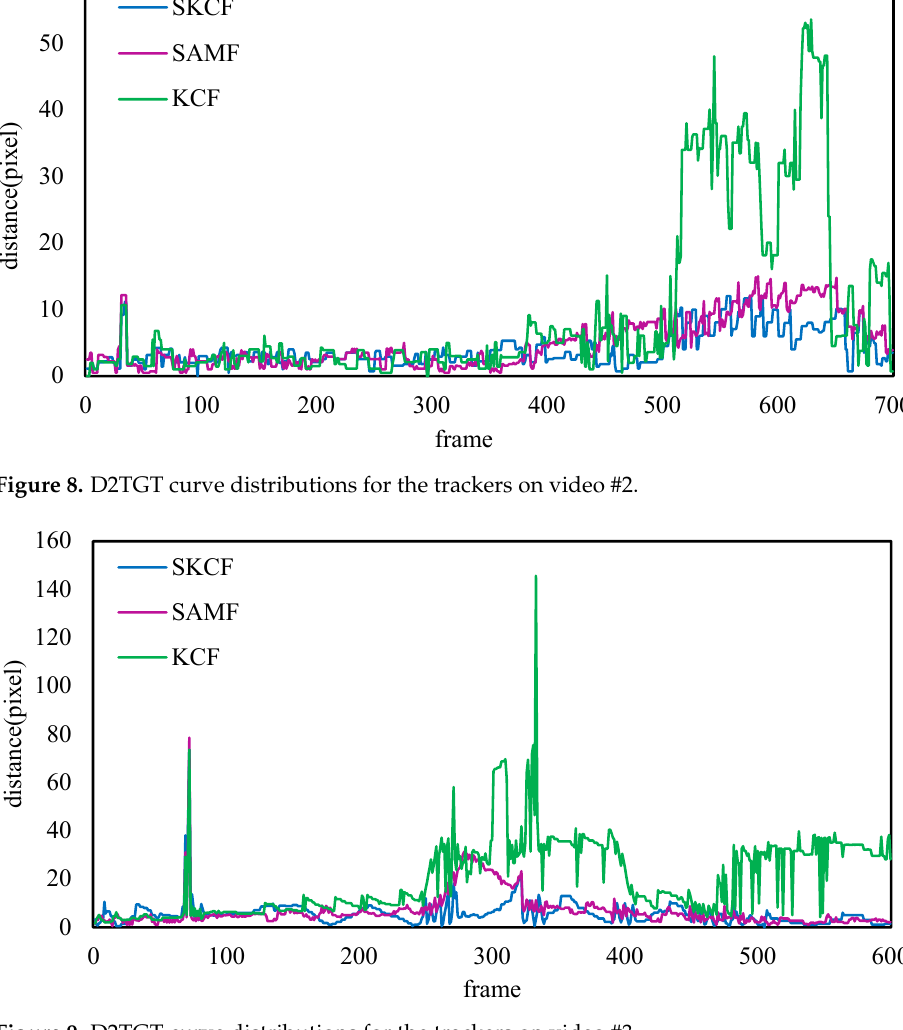
Figure 9. D2TGT curve distributions for the trackers on video #3.